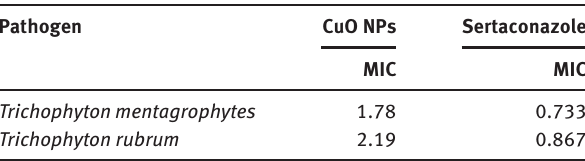
Table 1: Antidermatophytic activities of CuO nanoparticles (NPs) and sertaconazole against dermatophytes (mg/ml).